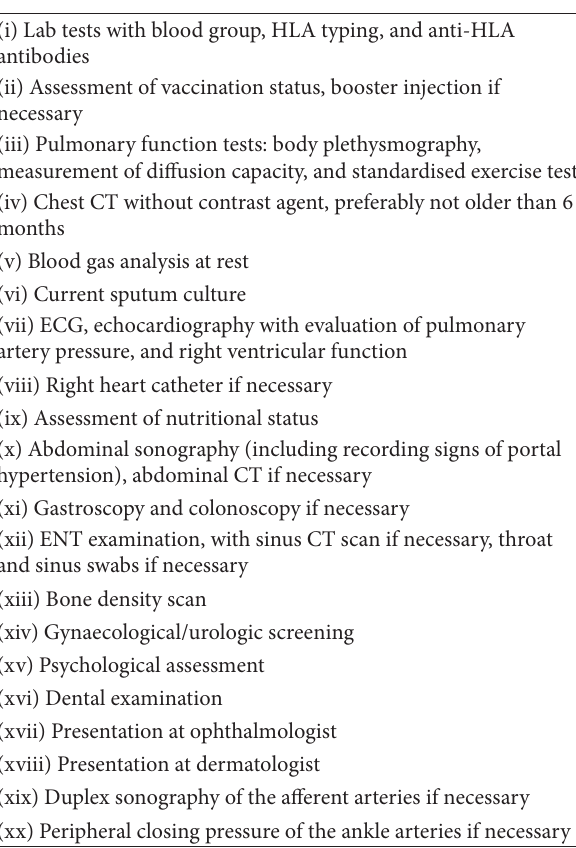
Table 1: Preparatory tests for LTX ∗